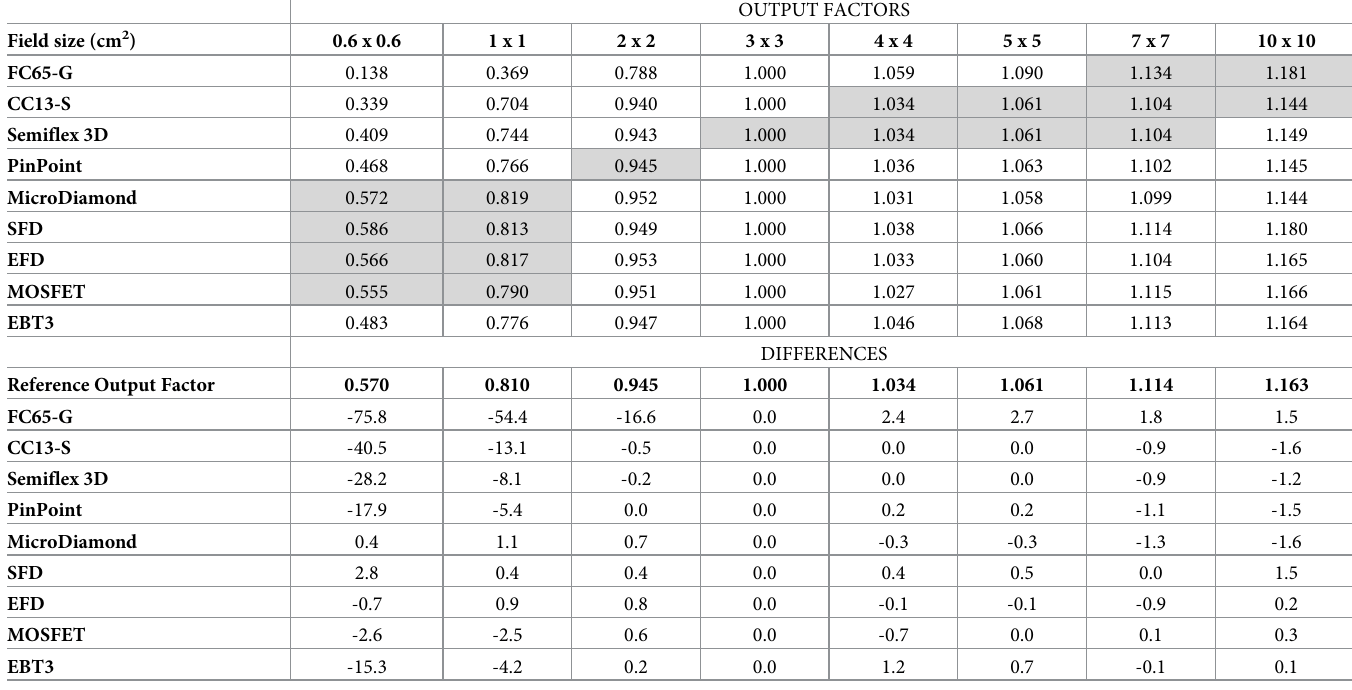
The shaded squares highlight the detectors used as a reference for each field size. The bottom of the table shows the difference (expressed as a percentage) between detector responses for each field size with respect to the chosen reference